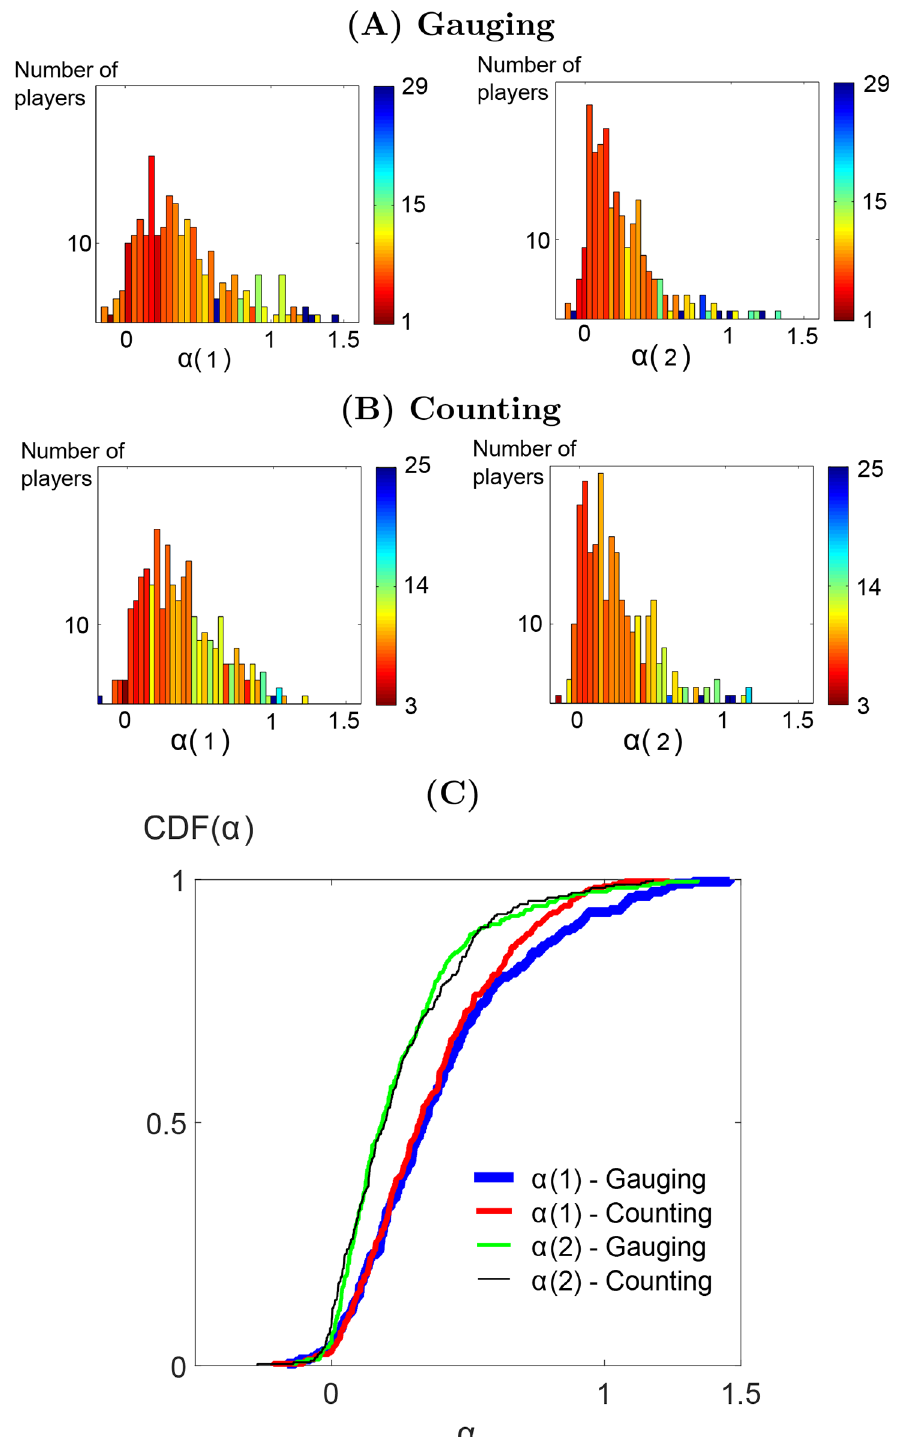
Fig 1. Influenceability over rounds and games. (A) Gauging game, (B) Counting game: distributions of the α α i (1) influenceability after the first round and i (2) influenceability after the second round for the time-varying influenceability model (1). The colormap corresponds to the average prediction RMSE of participants in each bin. For visualization purposes, one value at α i (1) = − 1.5 has been removed from the histogram in the gauging game, round 1. (There was only one individual with α i (1) = − 1.5. For this particular individual,